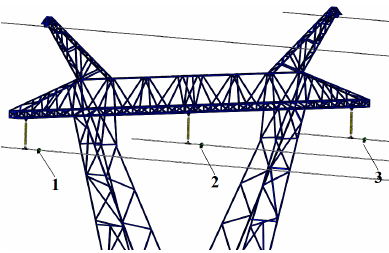
Figure 3. Application of voltage sensor in transmission line.